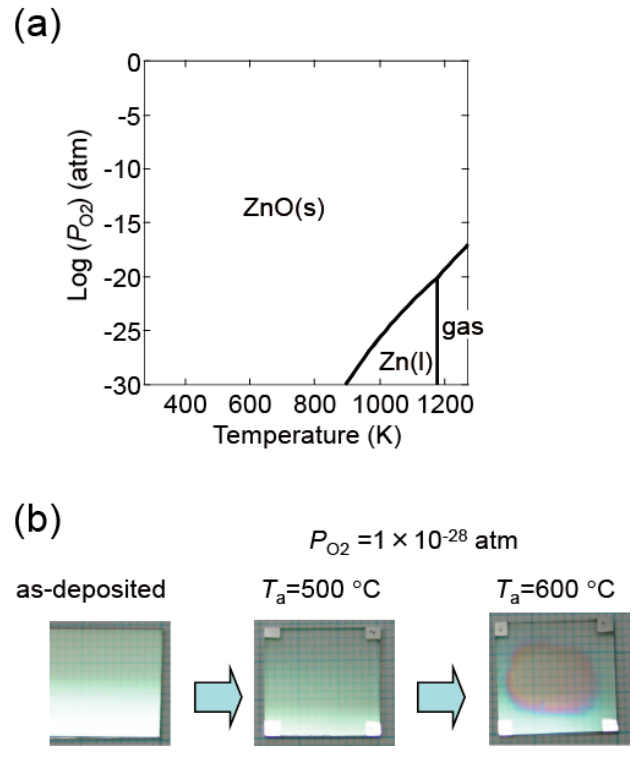
Figure 16. ( a ) Diagram indicating the conditions of thermodynamic equilibrium between ZnO and Zn + 1/2O 2 for pure ZnO; ( b ) images of a ZnO:Al (0.25 wt %) film before and after post-annealing at 500 and 600 °C at a P O2 of 1 × 10 − 28 atm using the Hall measurement system. 500 and 600 ◦ C at a P O2 of 1 × 10 − 28 atm using the Hall measurement